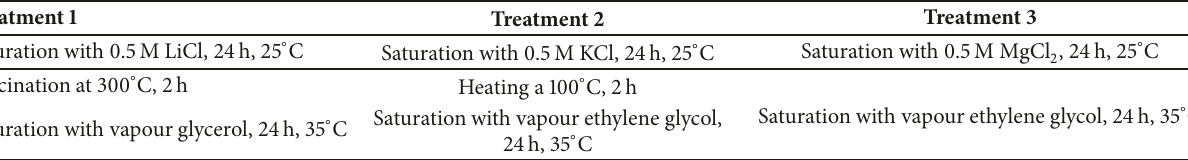
Table 1: Further tests for detailed identification of the clay